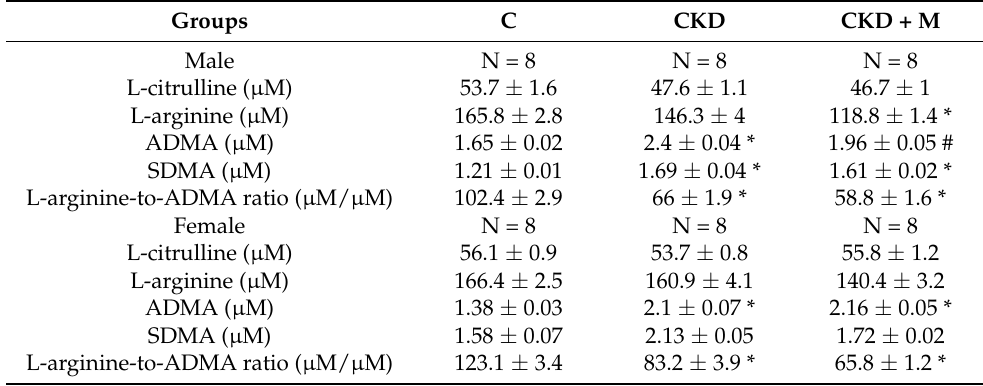
Table 4. Plasma levels of NO-related parameters.